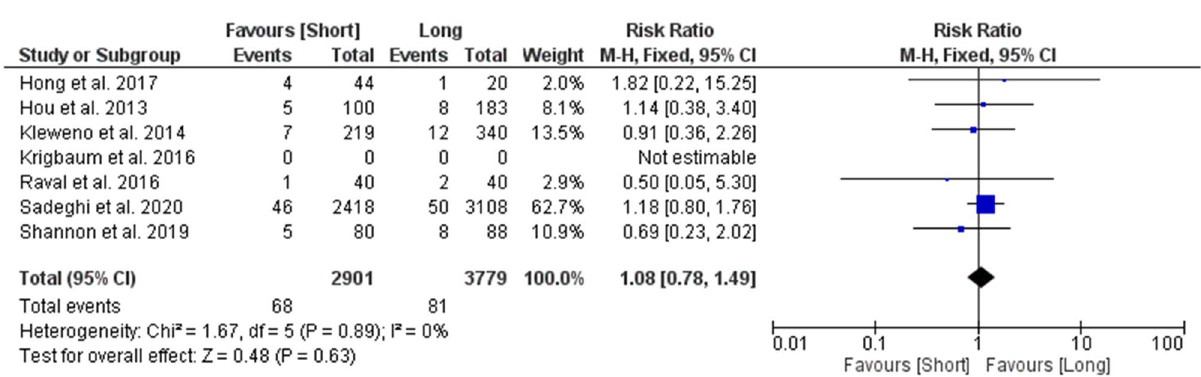
Figure 7. Forest plot of risk ratio for reoperation rates between long and short CMD groups. Blue boxes represent weighted mean values of each study. The black diamond represents the overall pooled weighted mean of all included studies.